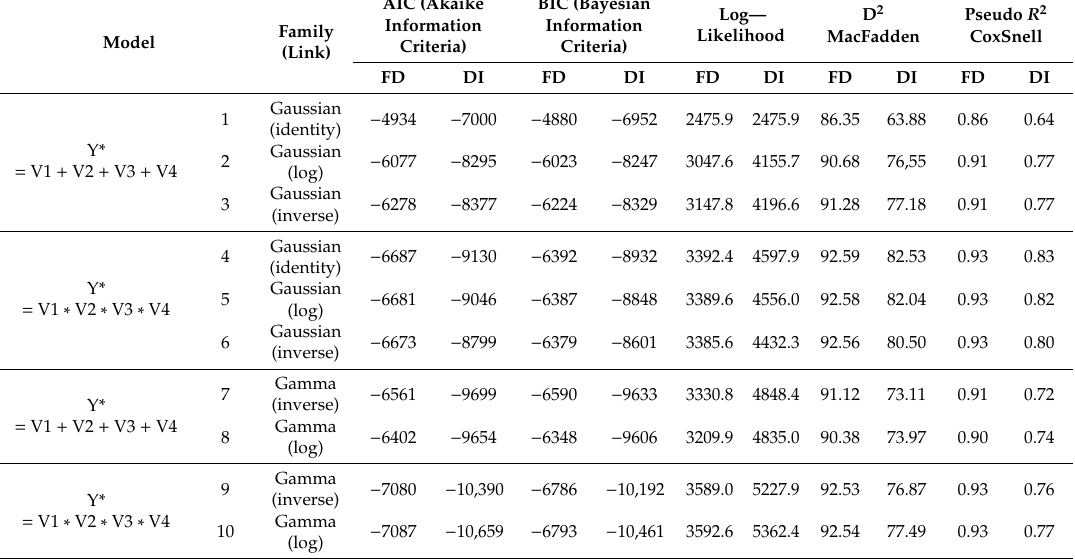
Table 9. Summary of the best-fit Generalized Linear Model (GLM) for footprint diameter (FD) and indentation depth